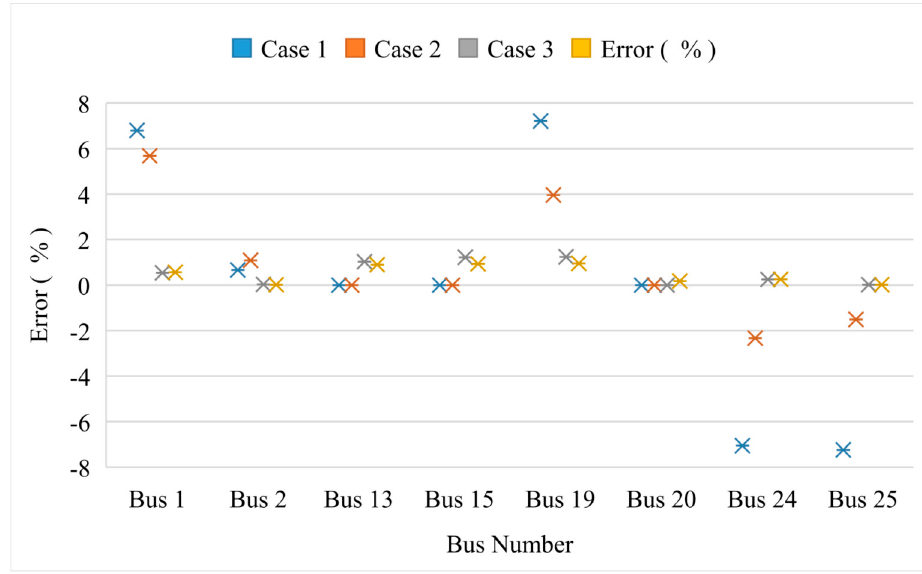
Figure 5. Comparison of errors in parameter estimation.